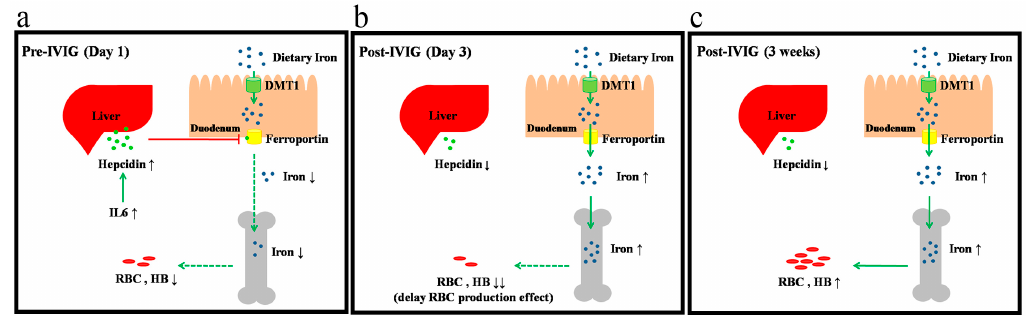
Figure 5. Proposed mechanism of hepcidin-induced hypoferremia and transient anemia in patients with Kawasaki disease. ( a ) Hemoglobin and iron levels were lower while plasma IL-6 and hepcidin levels were higher in patients with KD prior to IVIG administration; ( b ) After IVIG treatment, plasma hepcidin and hemoglobin levels significantly decreased; ( c ) There was a subsequent gradual increase in hemoglobin levels during the three weeks after IVIG treatment. The red solid line represents inhibition; the green solid line represents promotion; and the green dotted line represents reduction.